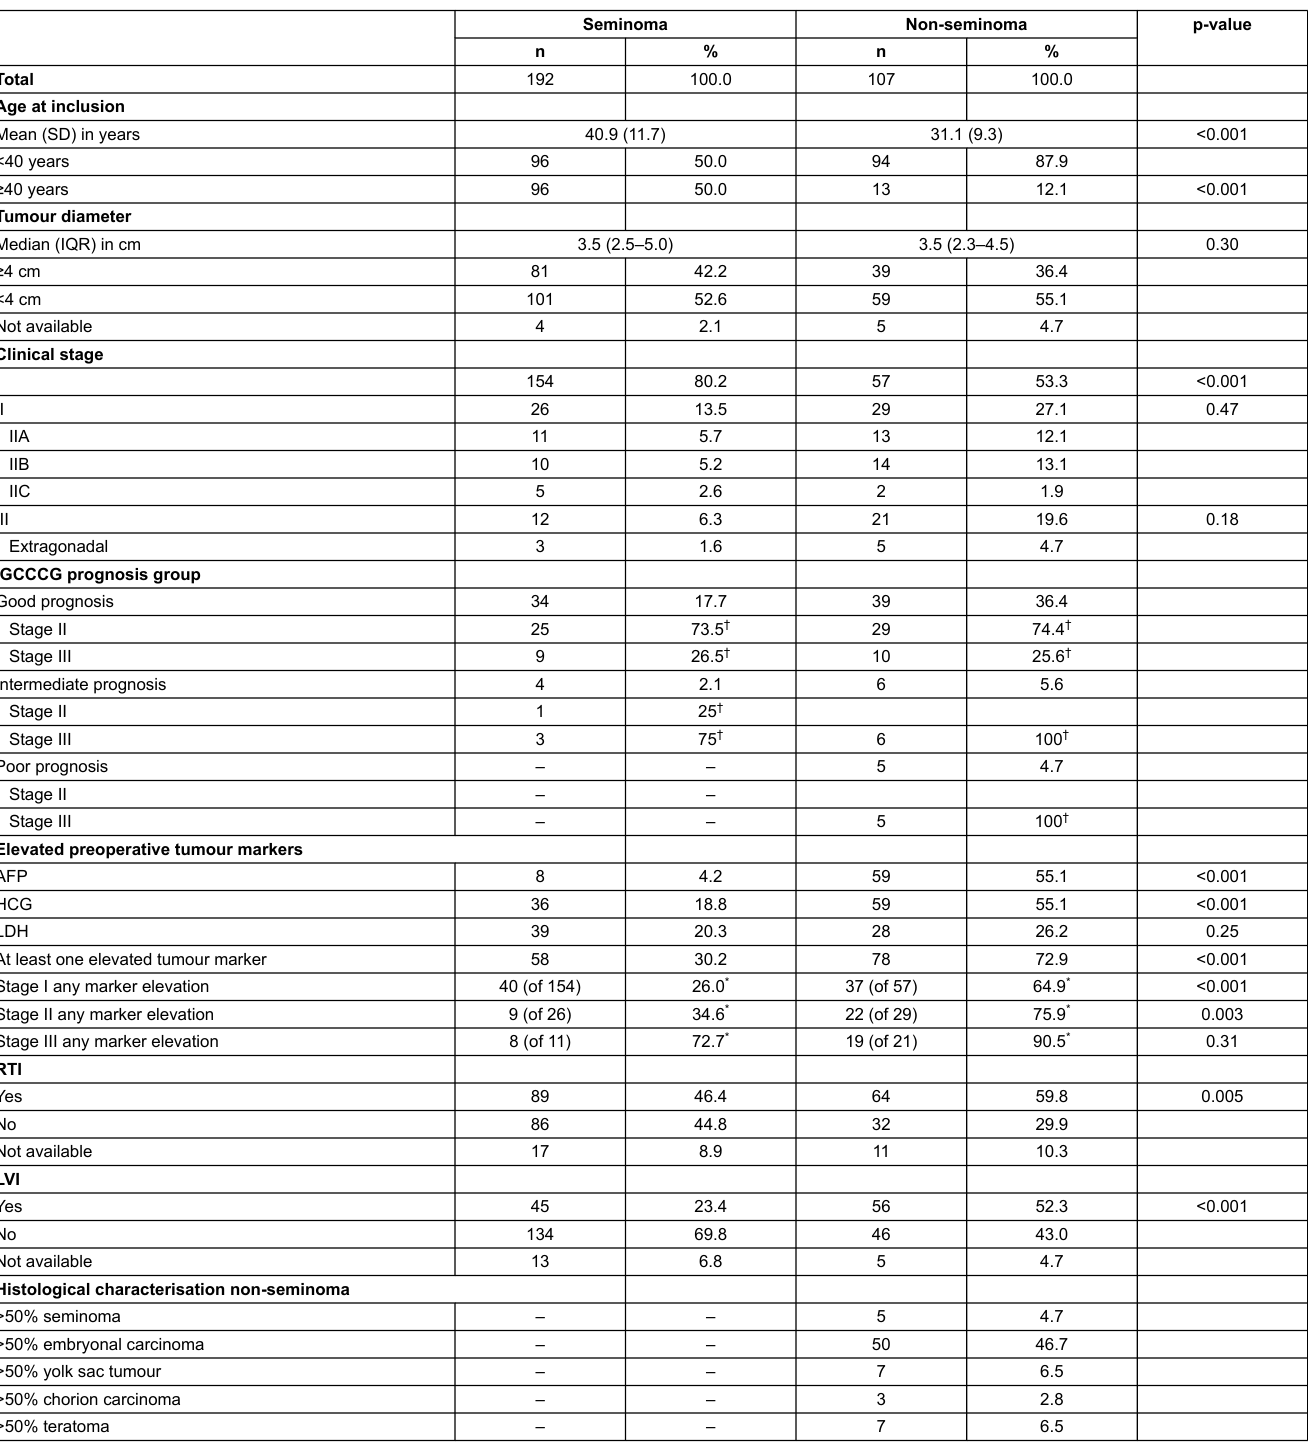
Table 1: Patient characteristics of the SAG TCCS cohort